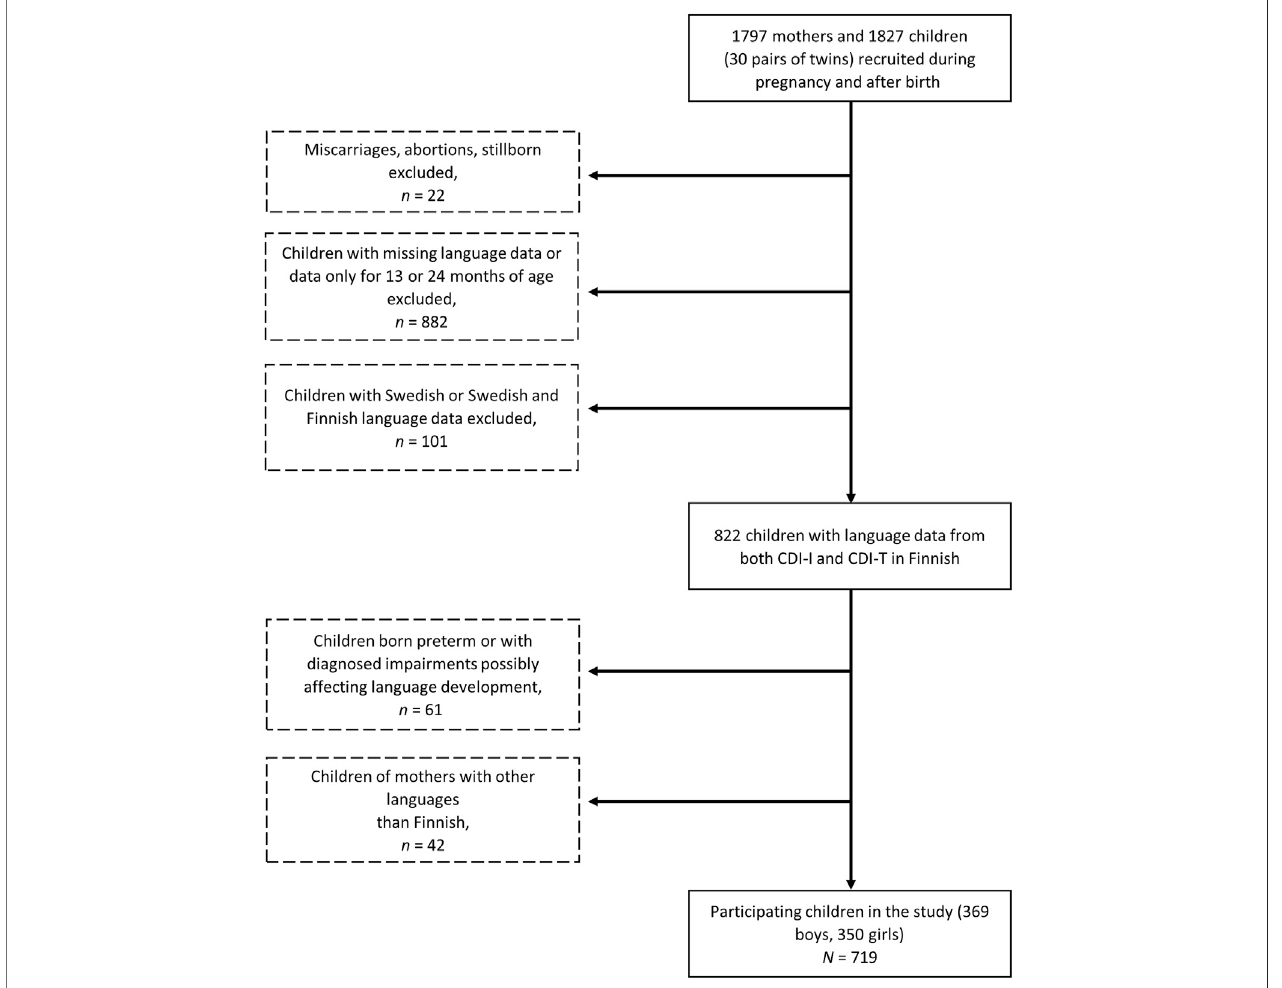
FIGURE 2 | Flowchart of the enrolment